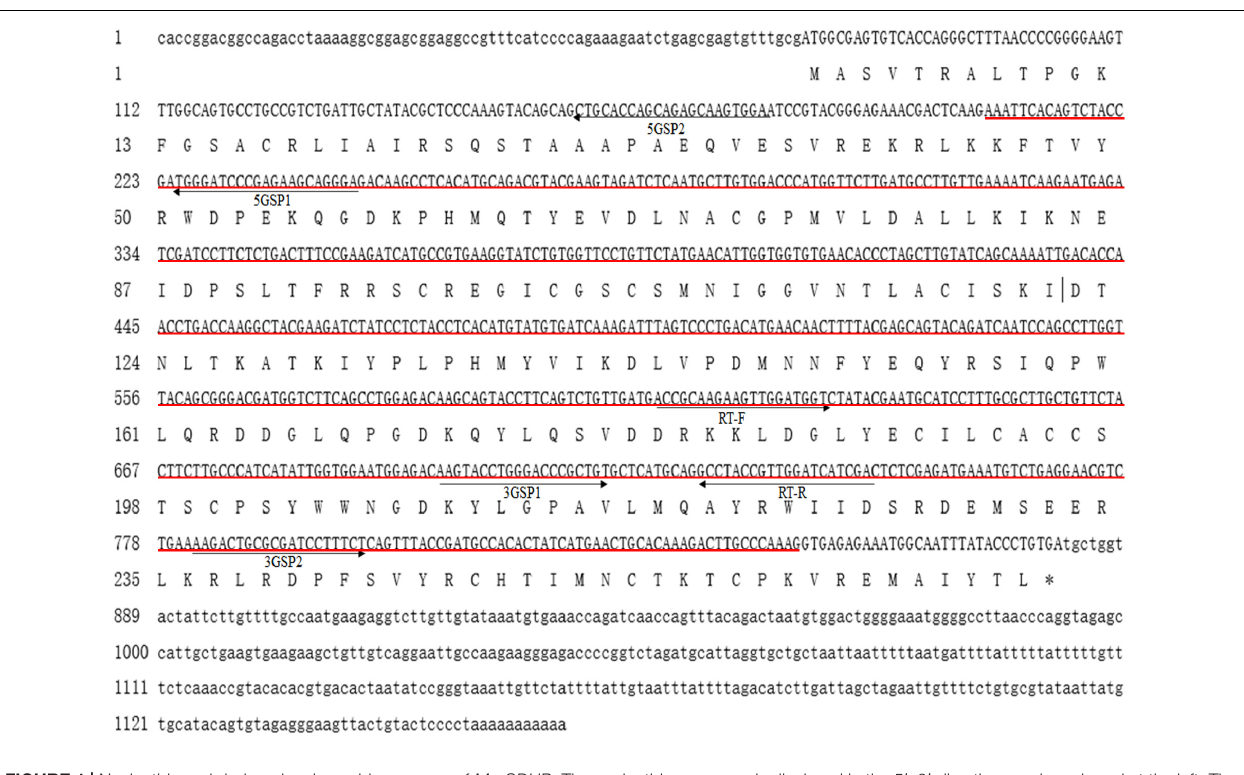
RNAi primer with T7 promoter site, shown in Table 2 .